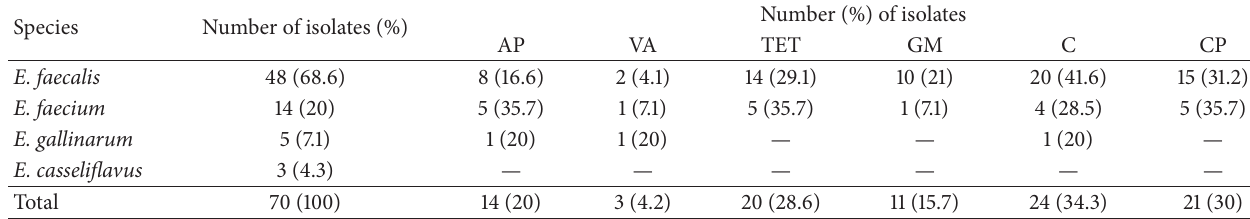
Table 3: Antibiotic resistance patterns among Enterococcus spp. isolated from waters.